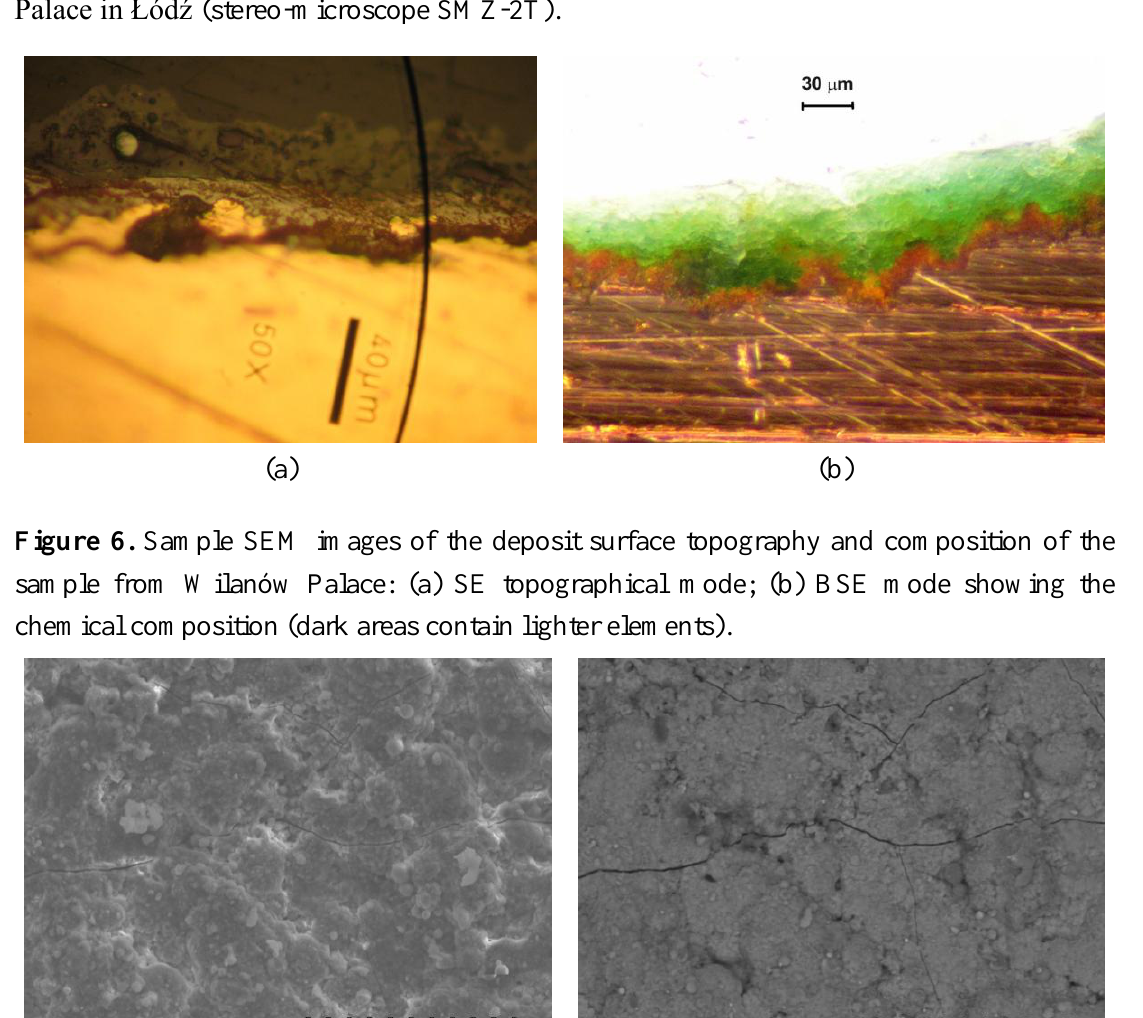
Figure 5. Polished cross-sections of the encrustation on copper sheets: (a) from Wilanów Palace in Warsaw (digital camera Canon Power Shot A 640); (b) from Karol Poznański Palace in Łódź (stereo-microscope SMZ-2T).